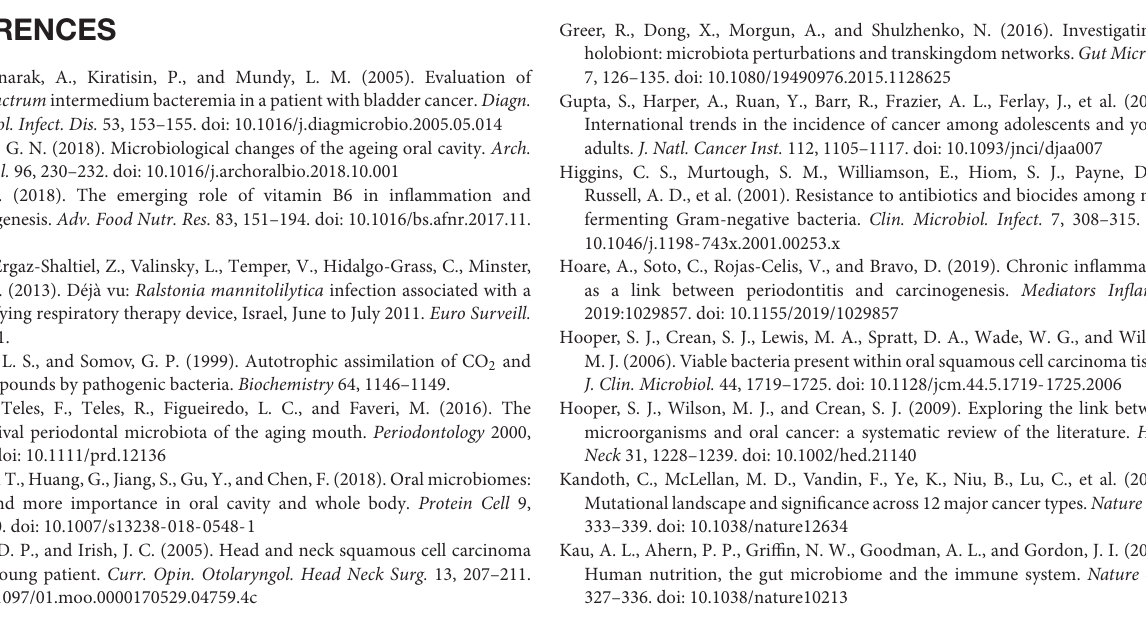
Supplementary Figure 1 | Histogram showing the reads that fell into different taxonomic levels of the bacteria by sample. Supplementary Figure 2 | Circle packing chart exhibiting the taxonomic tree of microbiota from younger and elder OSCC groups. Supplementary Figure 3 | Relative analysis of pooled genera from younger and elder OSCC groups with clinical